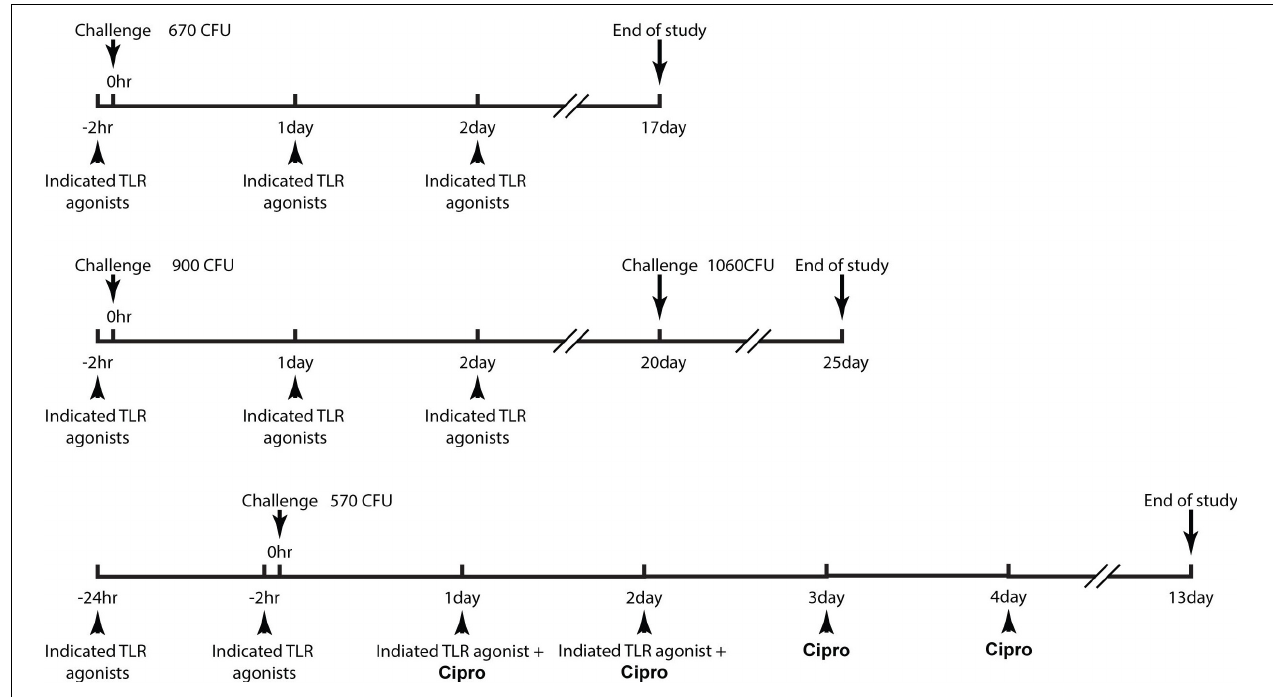
FIGURE 1 | Schematic diagrams demonstrating the dose regimen of the studies. Detailed description of the study design can be referred to the “experimental design of the efficacy studies” in the materials and methods section.